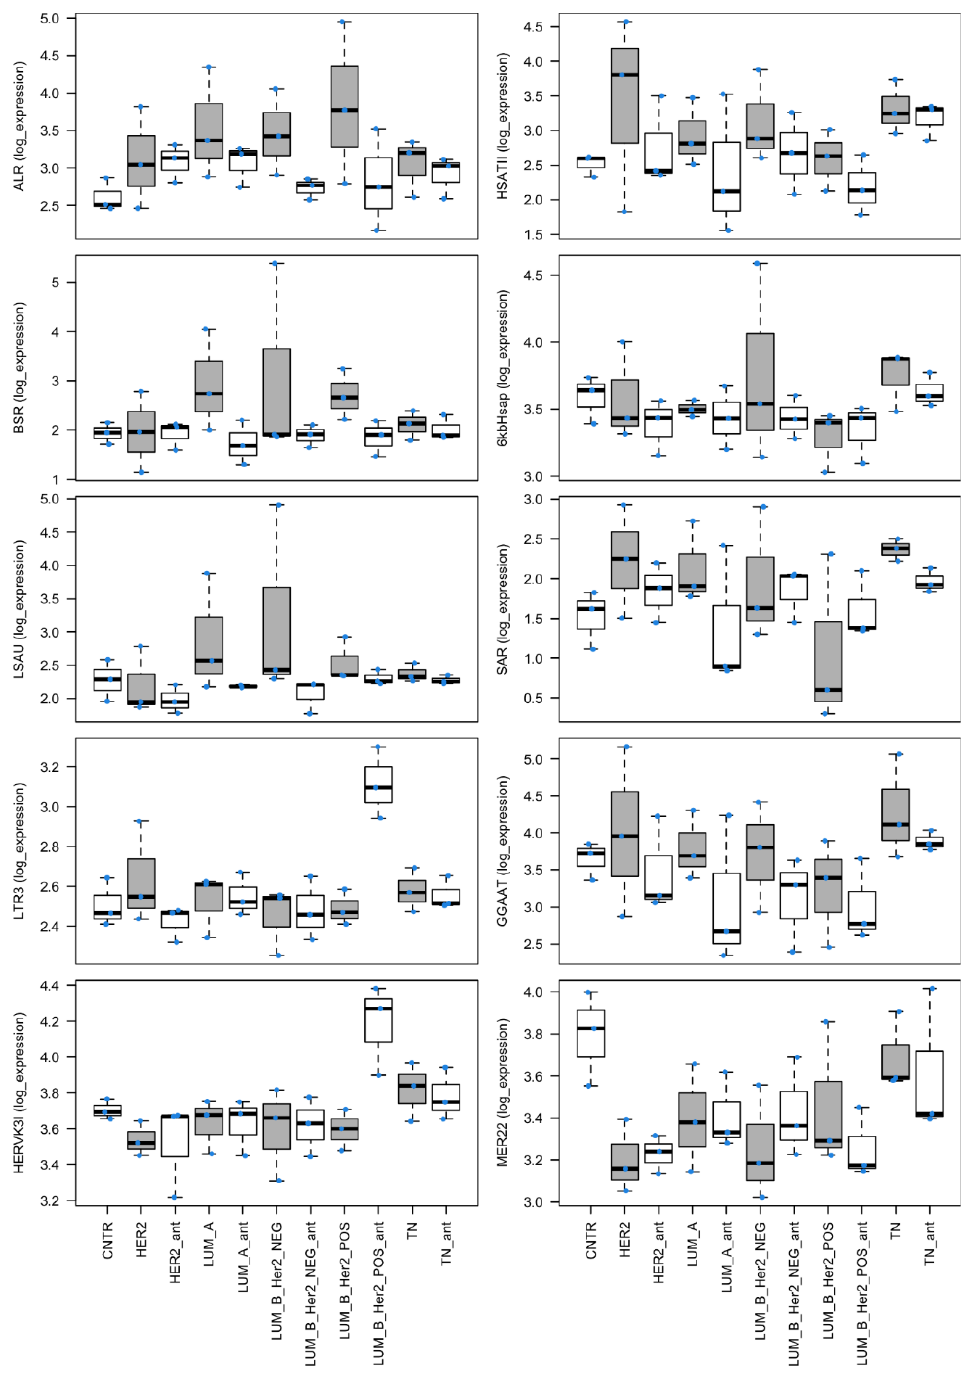
Figure 2. Whisker plots of the expression of selected RS in Log10. The cancerous specimens are plotted in